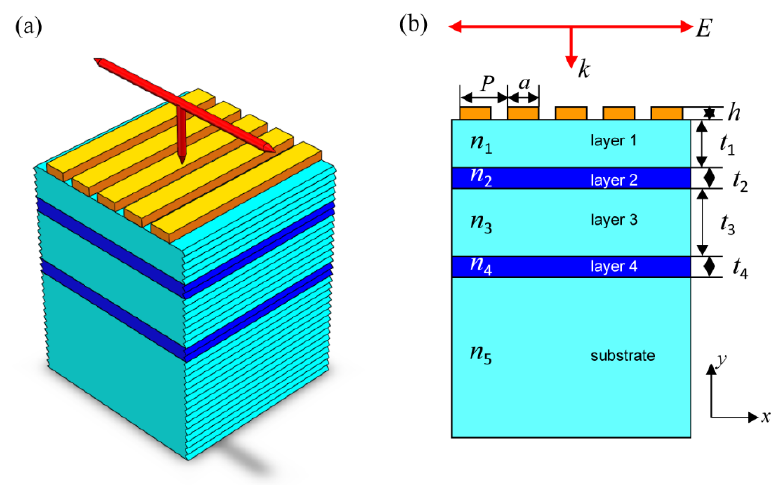
Figure 1. Schematic map of the proposed nanosystem: ( a ) Main view; ( b ) Side view.